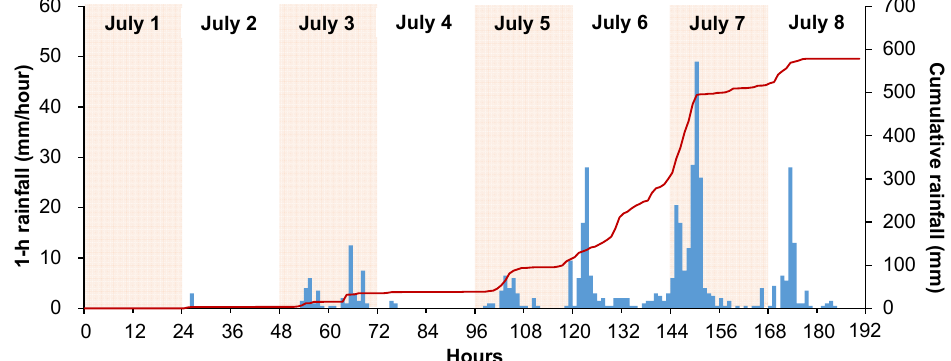
Figure 2. Hourly rainfall (blue bars) and cumulative rainfall (a red line) on 1–8 July 2018, at the Uwajima rainfall station.